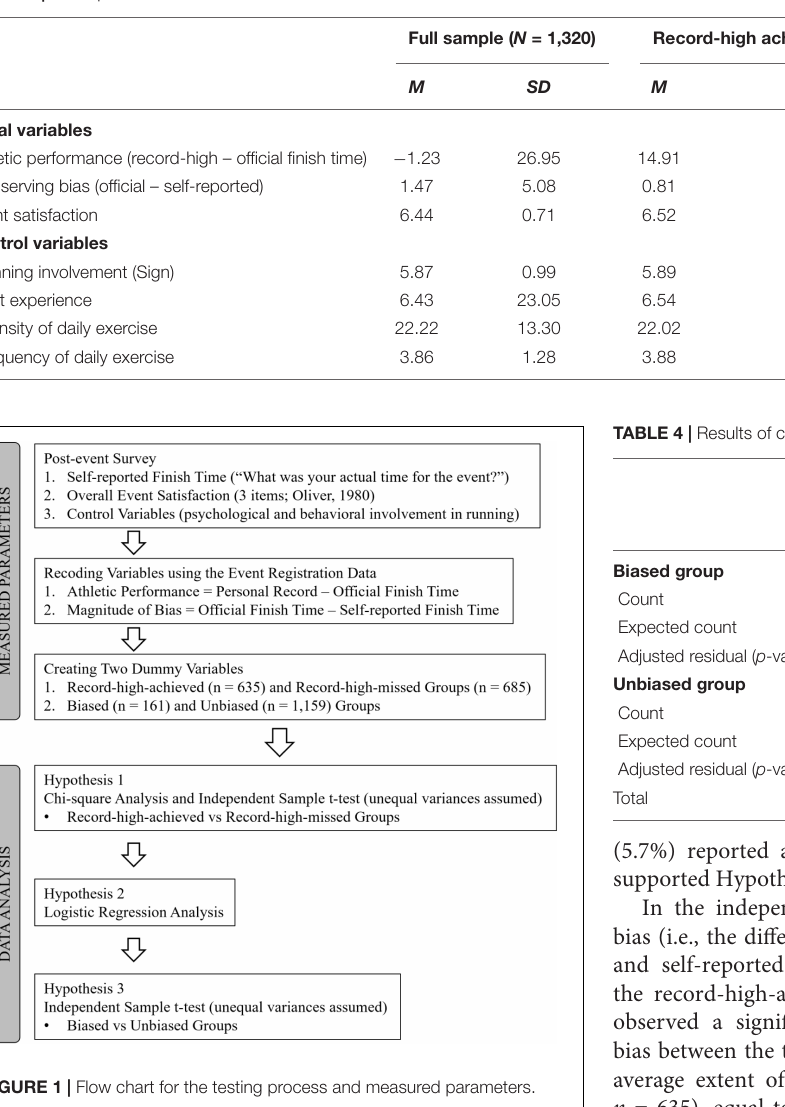
TABLE 3 | Descriptive statistics of focal and control variables.